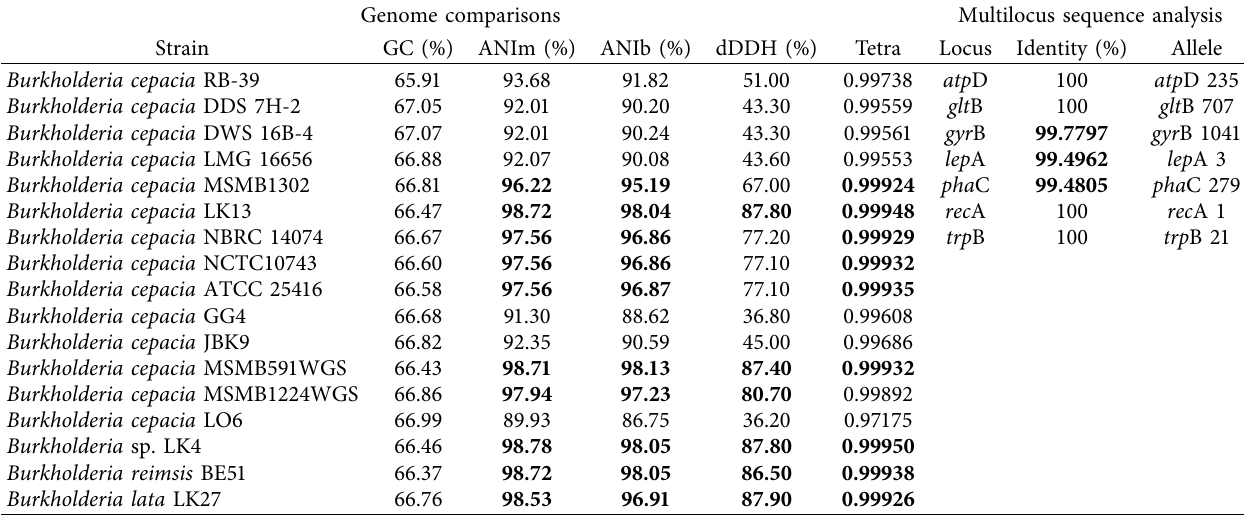
Figure 2: Consensus tree obtained from a neighbor-joining phylogenetic analysis using the Jukes-Cantor method (bootstrap with 1000 replicates) based on the concatenated full length of seven housekeeping and 16S rDNA gene of B. cepacia COPS strain compared to reference sequences of Bcc members. Table 4: Genomic comparisons between Burkholderia cepacia COPS and B. cepacia strains based on genome comparisons and multilocus sequence